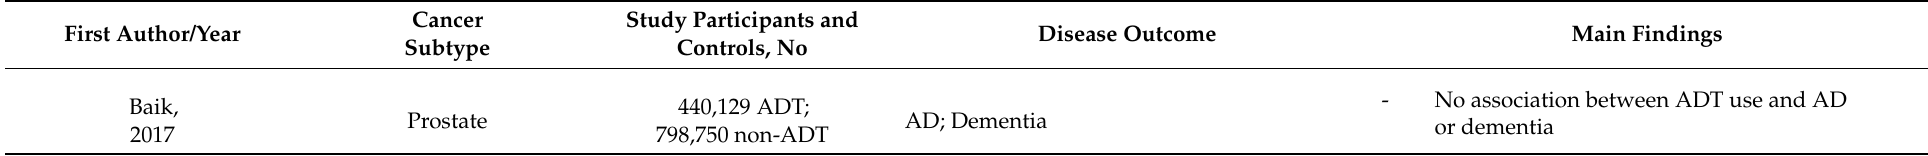
Table A4. Overview of neurodegenerative diseases in older cancer survivors according to the systematic literature